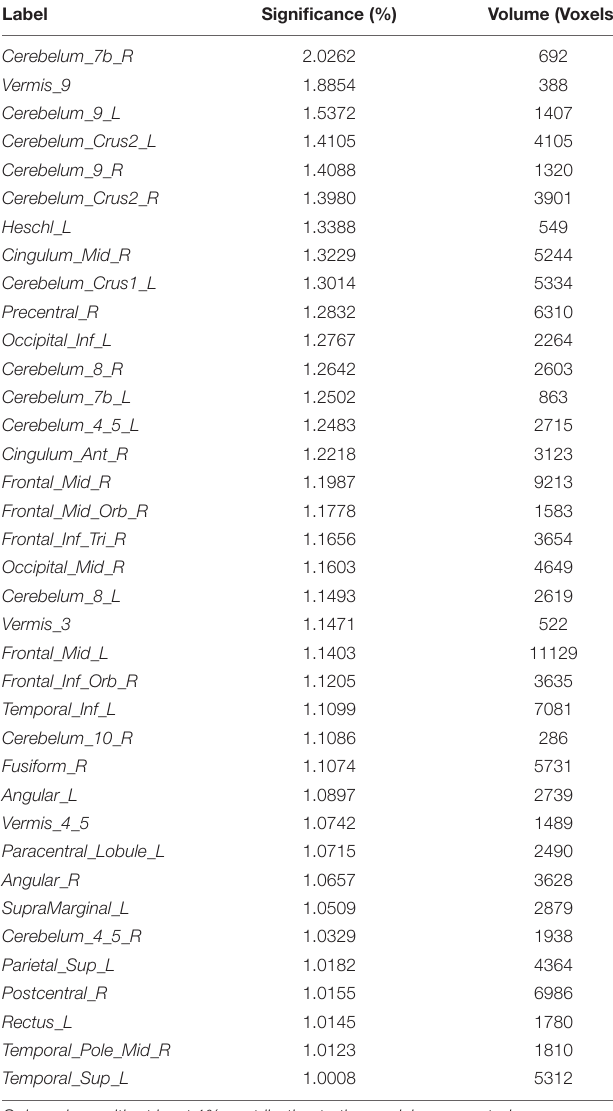
TABLE 3 | ROI weights and voxel sizes of the circuit predicting the CTQ-Emotional neglect for HC.